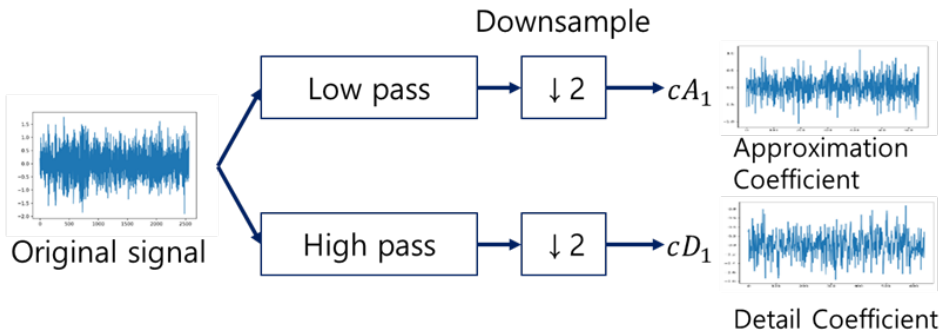
Figure 3. Procedure of discrete wavelet